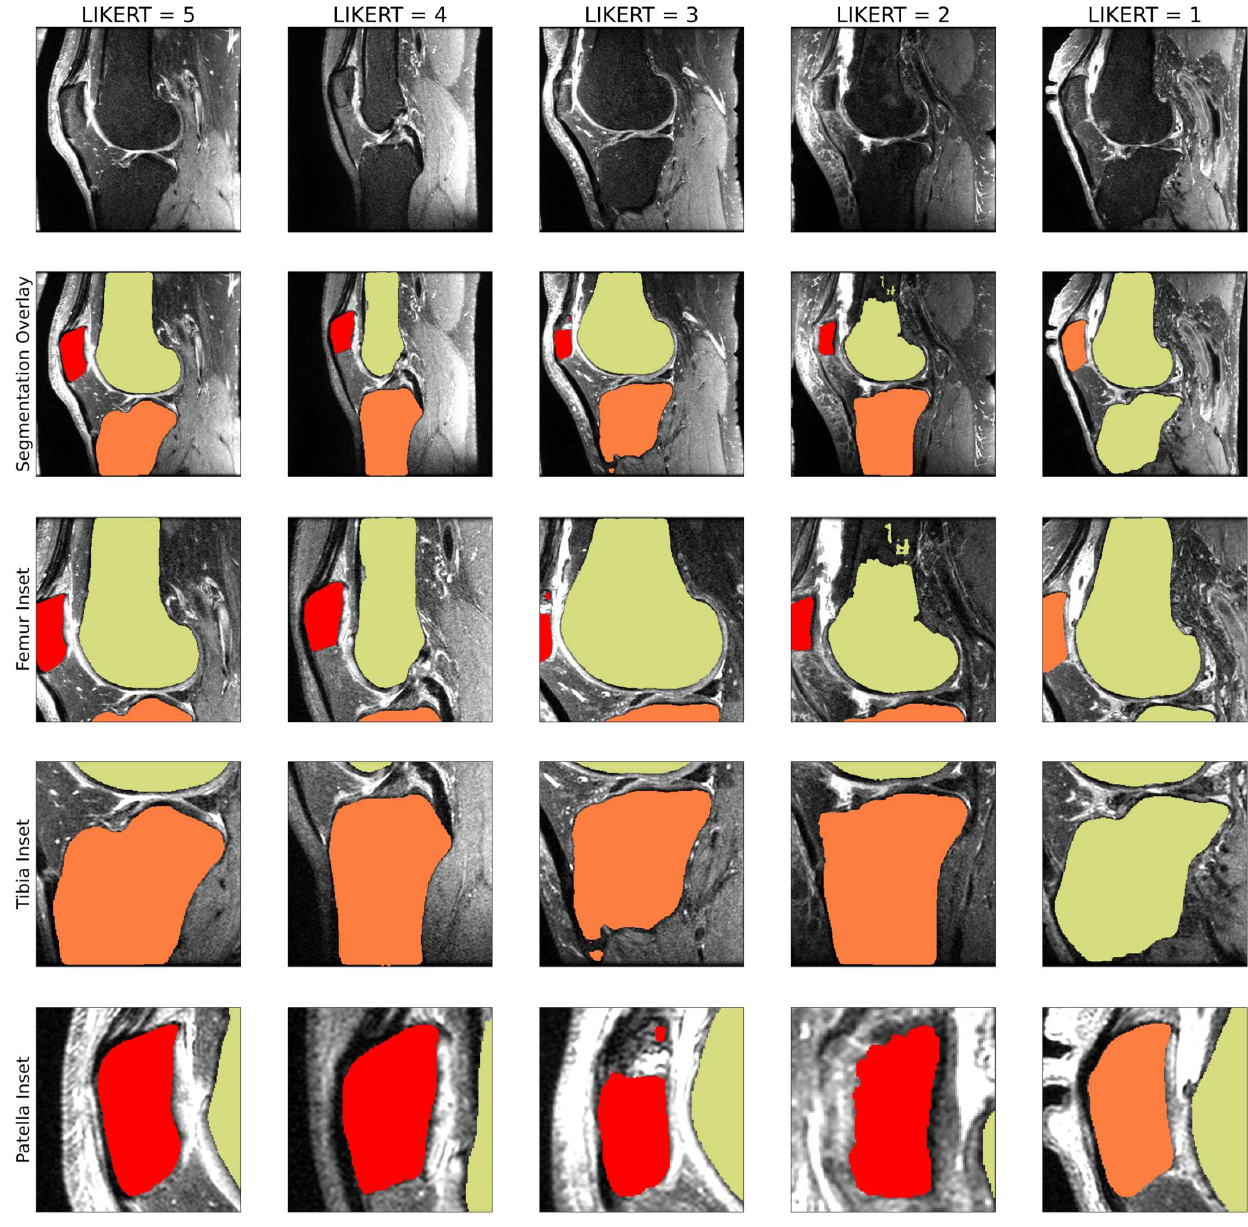
Figure 5. 1–5 LIKERT bone segmentation scores overlaid on ground truth knee scans. In